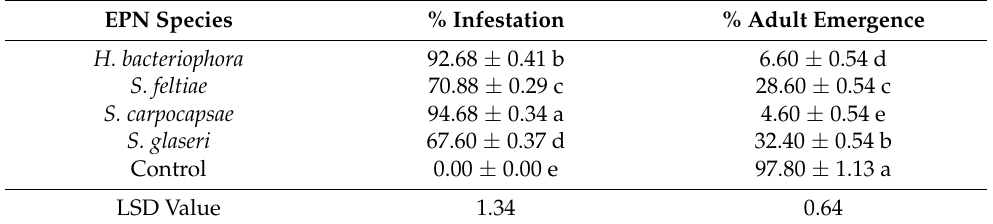
Table 1. Effect of various species of entomopathogenic nematodes on the % infestation and adult emergence of red palm weevil based on 5th instar larvae